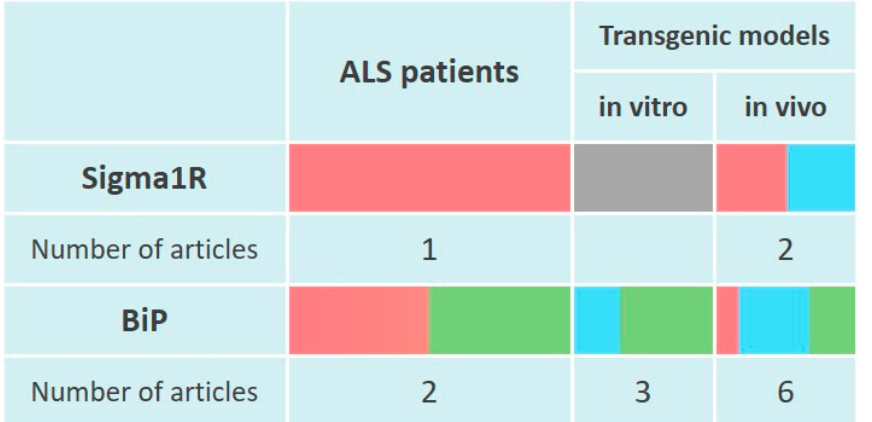
Figure 3. Changes of Sigma1R and BiP chaperones expression in the pathogenesis of amyotrophic lateral sclerosis. The table reflects experimentally recorded changes in the expression of Sigma1R and BiP chaperones, denoted in relative units, according to Sections 5.1 and 5.2. To visualize mRNA or protein levels following markers were used: green—content increased, blue—content did not change, red—content decreased, grey—not enough data.